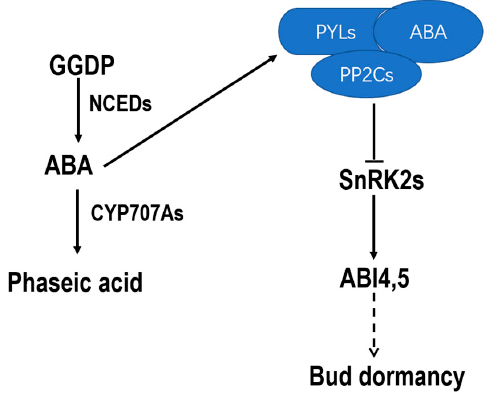
Figure 2. Model of ABA biosynthesis, metabolism, and signaling in pear modified according to Arabidopsis thaliana . ABA is synthesized from geranylgeranyl diphosphate ( GGDP) by 9- cis - epoxycarotenoid dioxygenases (NCEDs), and then degraded by CYP707As to phaseic acid. ABA is